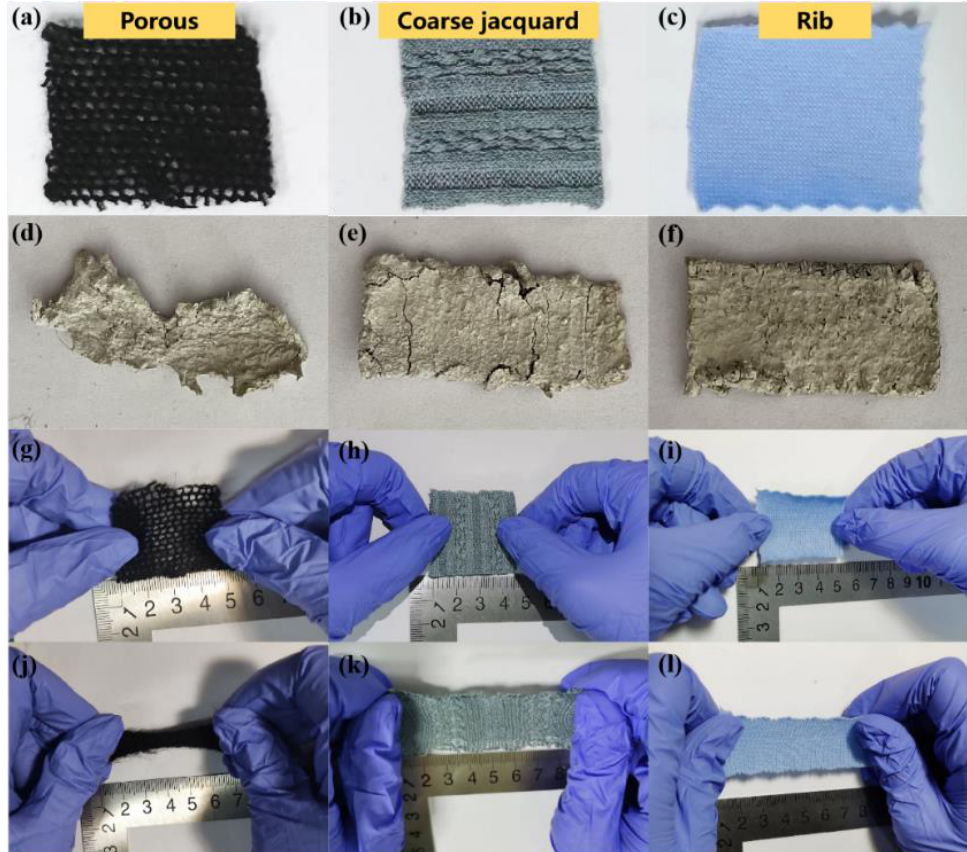
Figure 10. ( a ) Porous fabric; ( b ) Coarse jacquard fabric; ( c ) Rib fabric; ( d ) Porous fabric after conduc- tive treatment; ( e ) Coarse jacquard fabric after conductive treatment; ( f ) Rib fabric after conductive treatment; ( g ) Porous fabric before stretching; ( h ) Coarse jacquard fabric before stretching; ( i ) Rib fabric before stretching; ( j ) Porous fabric after stretching; ( k ) Coarse jacquard fabric after stretching; ( l ) Rib fabric after stretching.